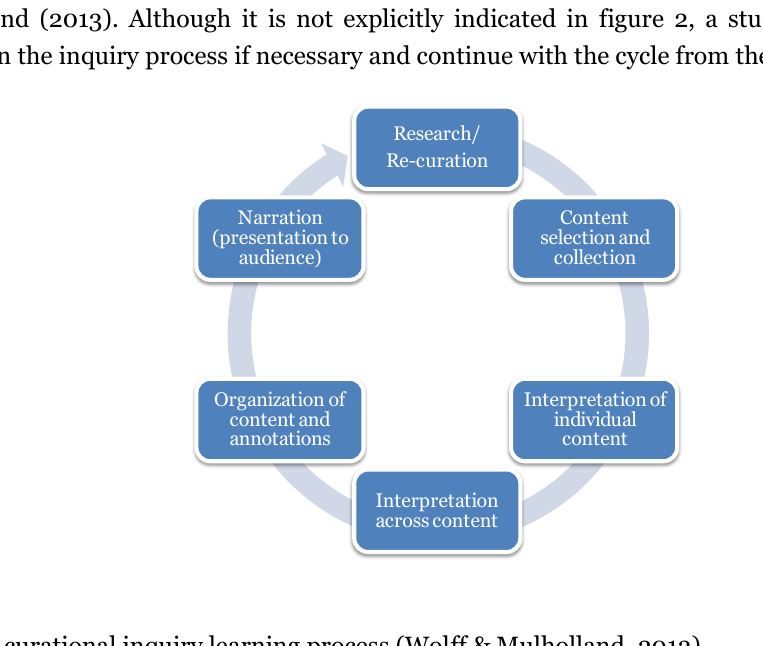
Figure 2. The curational inquiry learning process (Wolff & Mulholland,